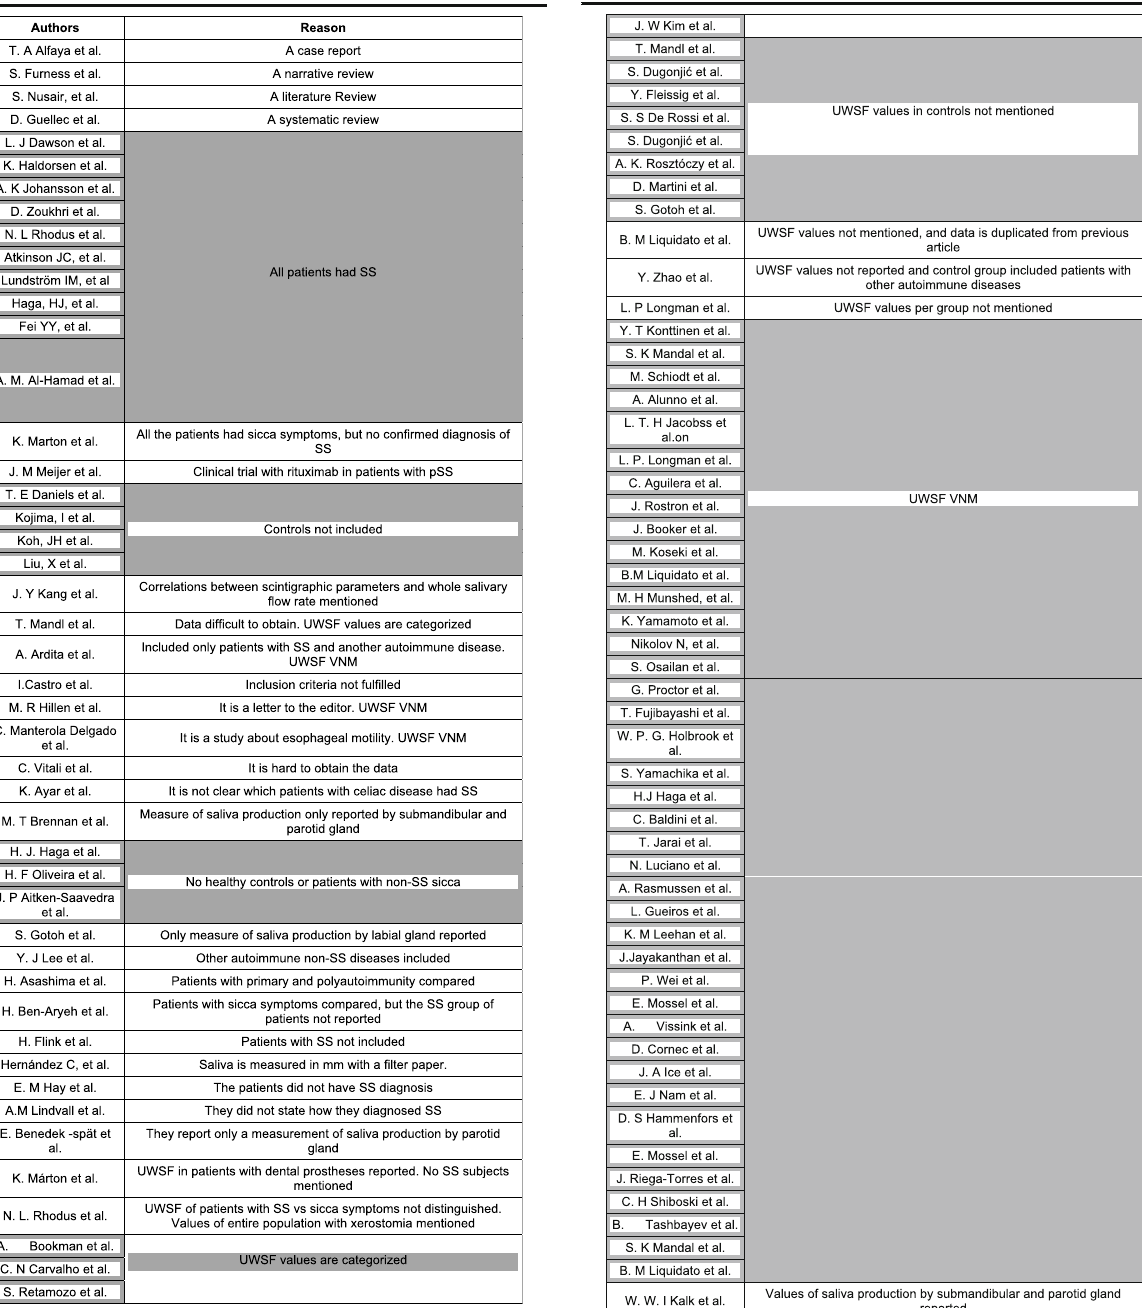
Table 2 Reasons for excluding the discarded articles